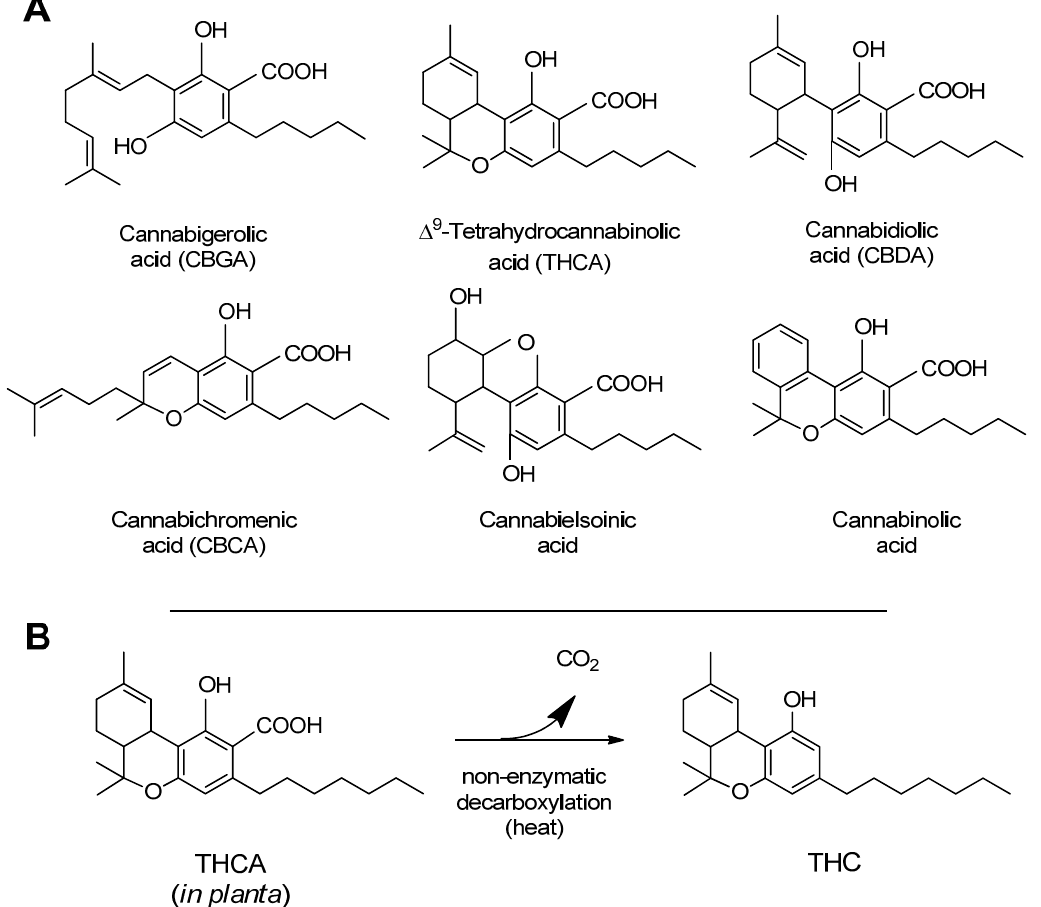
Figure 1. ( A ) Structure of the most common cannabinoids found in Cannabis plants. All the compounds have been represented in their acidic, native form, and with a pentylic side